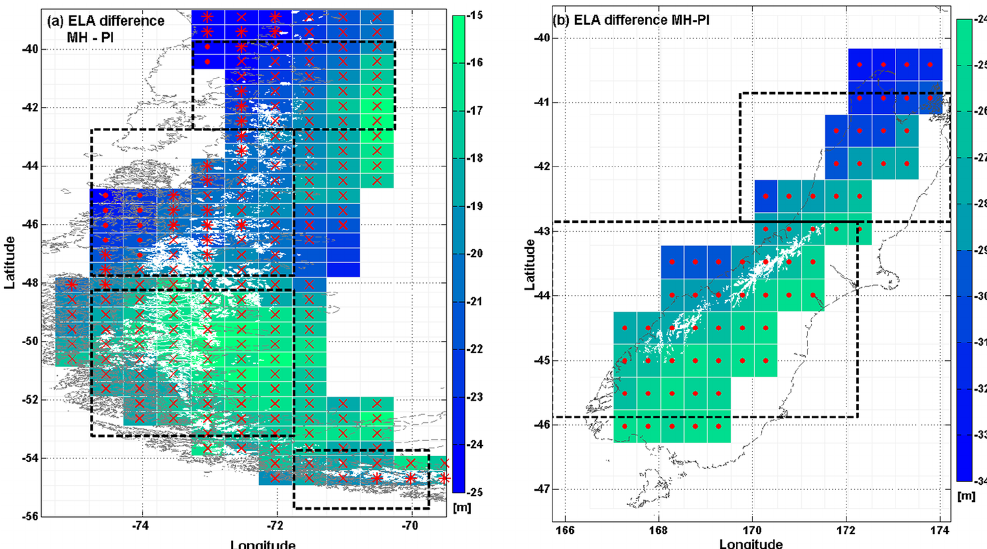
Figure 6. Mid-Holocene minus pre-industrial ELA differences. Points indicate that the six models have a negative sign in the differences; asterisks indicate that five models have a negative sign and crosses indicate that four models have a negative sign. White lines indicate actual glacier outlines (Randolph Glacier Inventory 3.2). (a) Patagonia and (b) New Zealand.